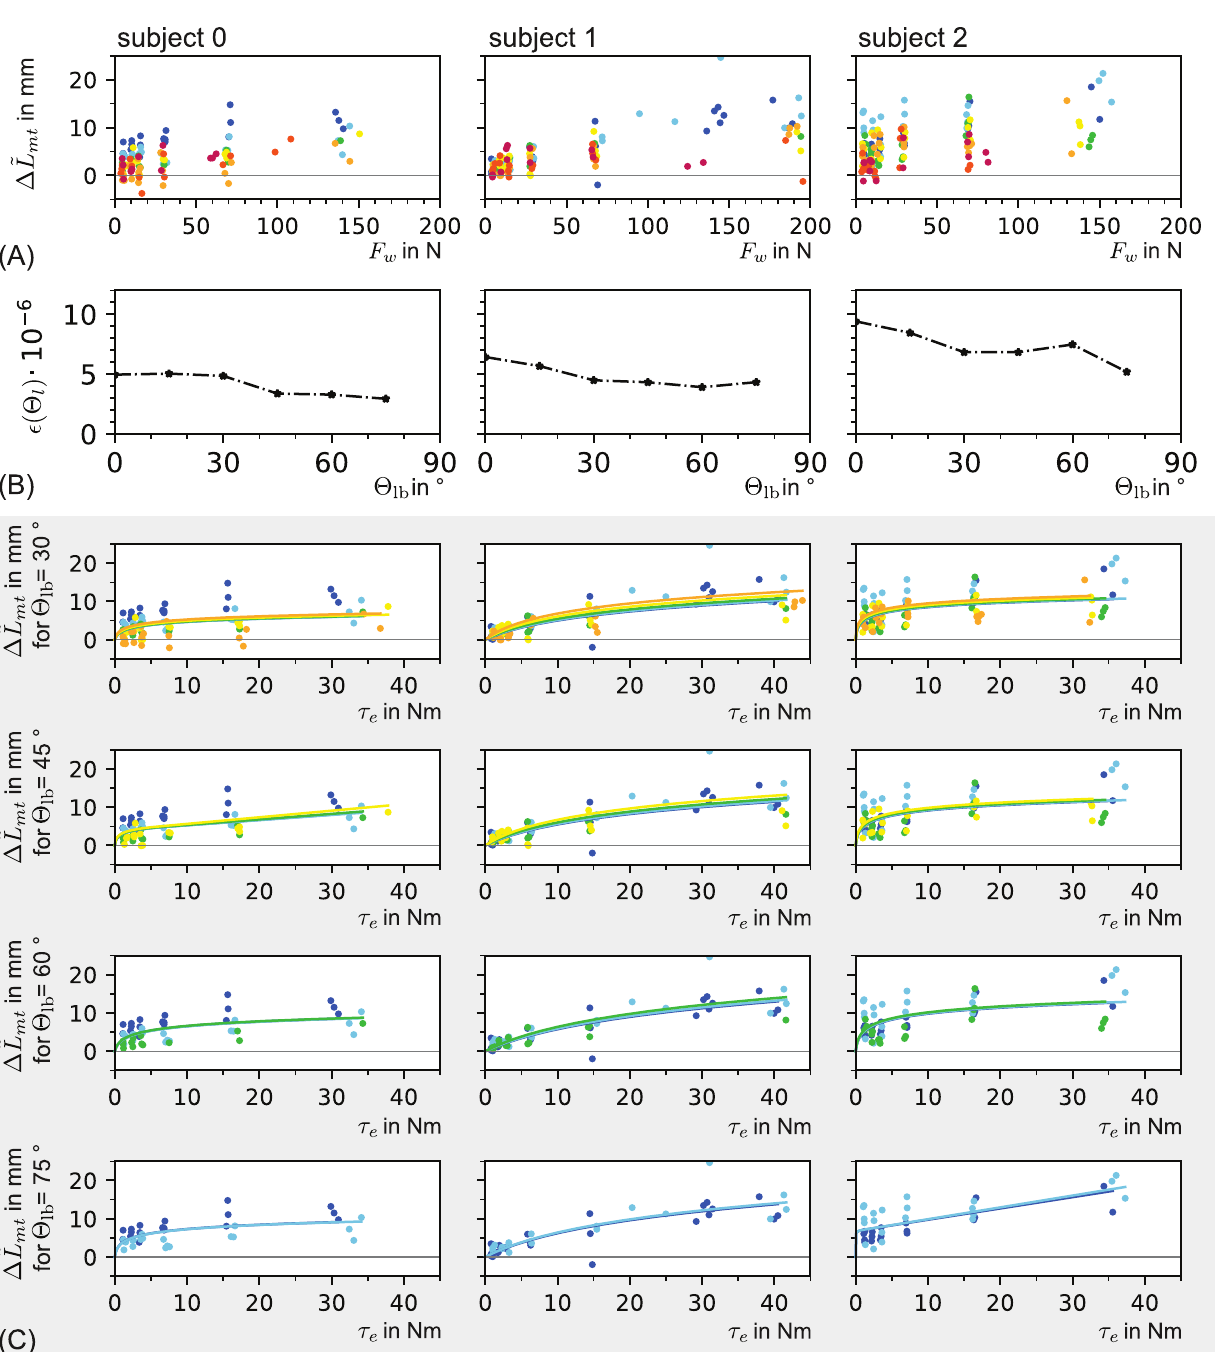
Fig 12. Manually extracted data and corresponding fits for three subjects in column-wise arrangement. (A) Myotendinous junction displacement D ~ L as manually extracted from B-Mode videos plotted over the wrist force F . (B) Normalized costs of each angular subset fit (see Eq (43)). (C) Fits of w mt the angular subsets Θ = 30 � , Θ = 45 � , Θ = 60 � , Θ = 75 � . (Same color coding as in Fig 7). lb lb lb lb